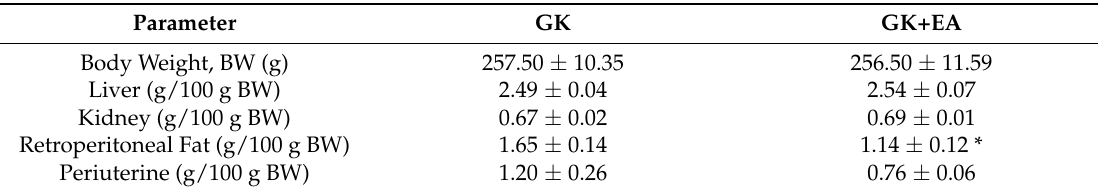
Table 1. Morphometric parameters of diabetic female Goto Kakizaki (GK) rats after oral treatment with